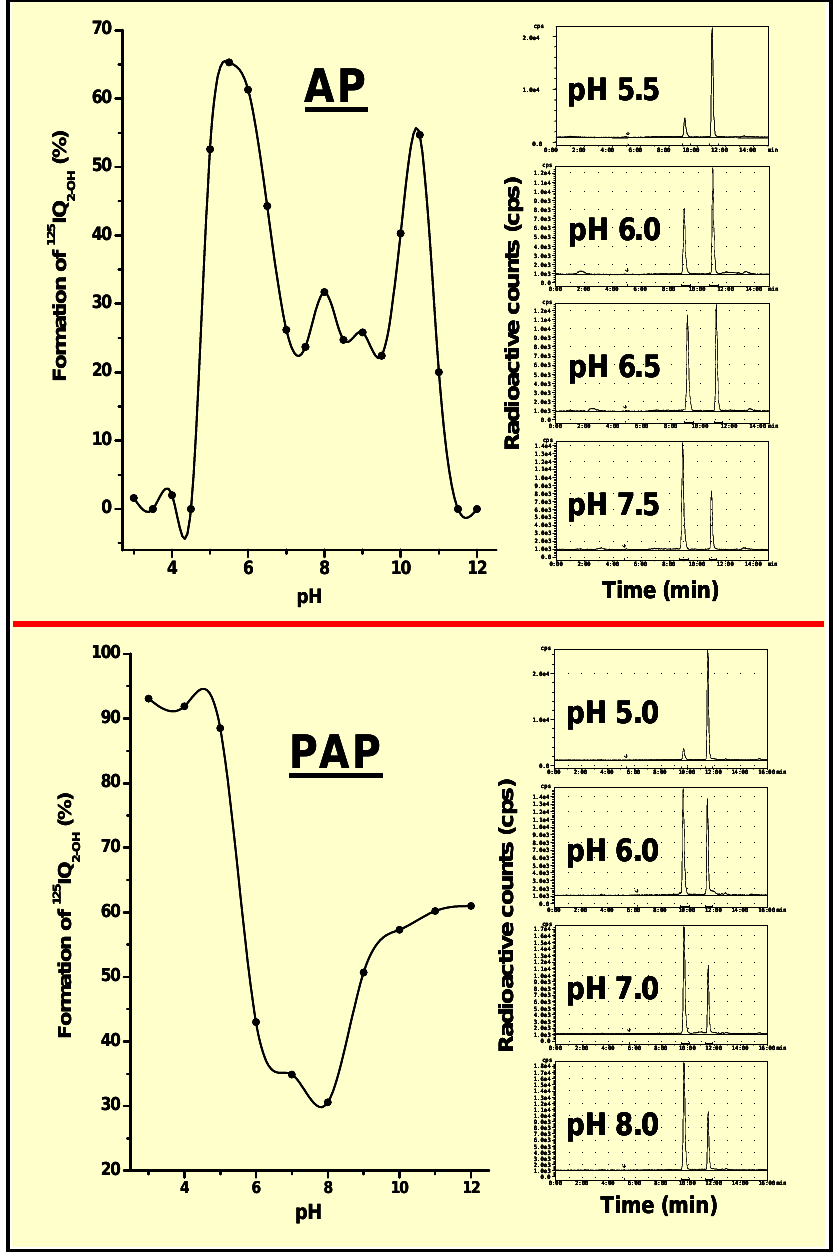
Figure 4. Hydrolysis of 125 IQ following 5-min incubation in AP or PAP at 2–P various pH values, indicating that dephosphorylation is favored at lower